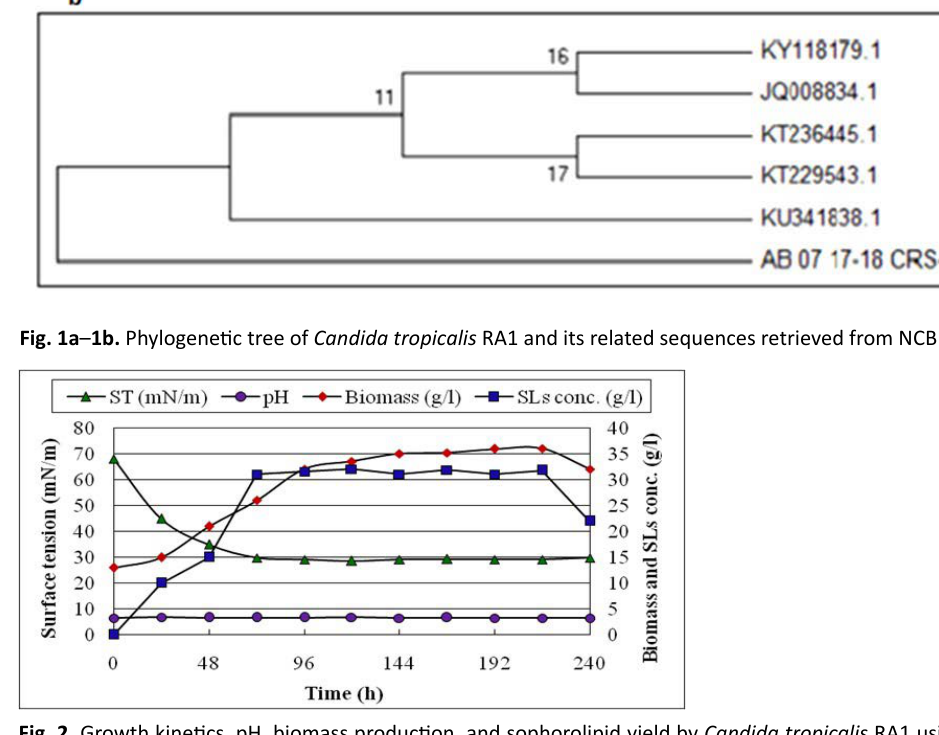
Fig. 2. Growth kinetics, pH, biomass production, and sophorolipid yield by Candida tropicalis RA1 using minimal salt medium + 2% soya oil (w v -1 ), plotted as a function of time (240